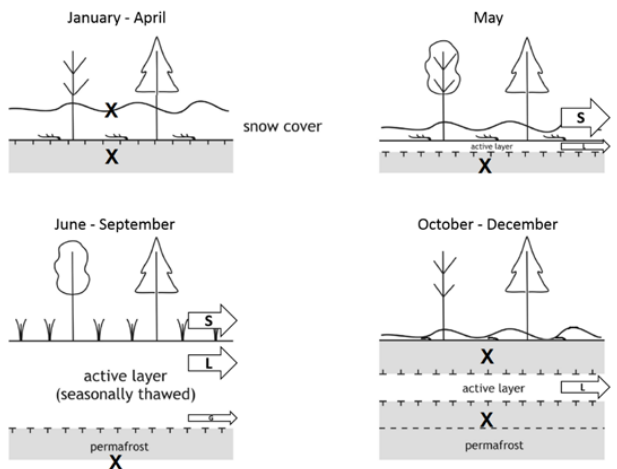
Figure 9. Conceptual model for Arctic watersheds hydrology. The cross corresponds to low interactions. The arrows represent the distribution of surface (S), lateral (L) and groundwater (G) flows depending on the snowmelt and the freeze ‐ unfreeze processes of permafrost. The average ratio is 60/40 according to Carey and Woo (1999). Adapted from Tananaev (2015) [65] and Hülsmann et al. (2015) [38].